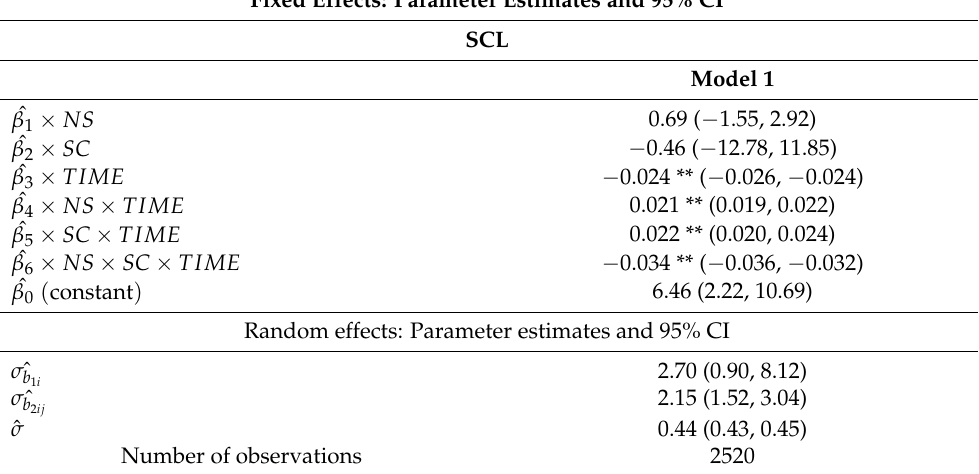
Table 2. Parameter estimates for the SCL. Fixed Effects: Parameter Estimates and 95%